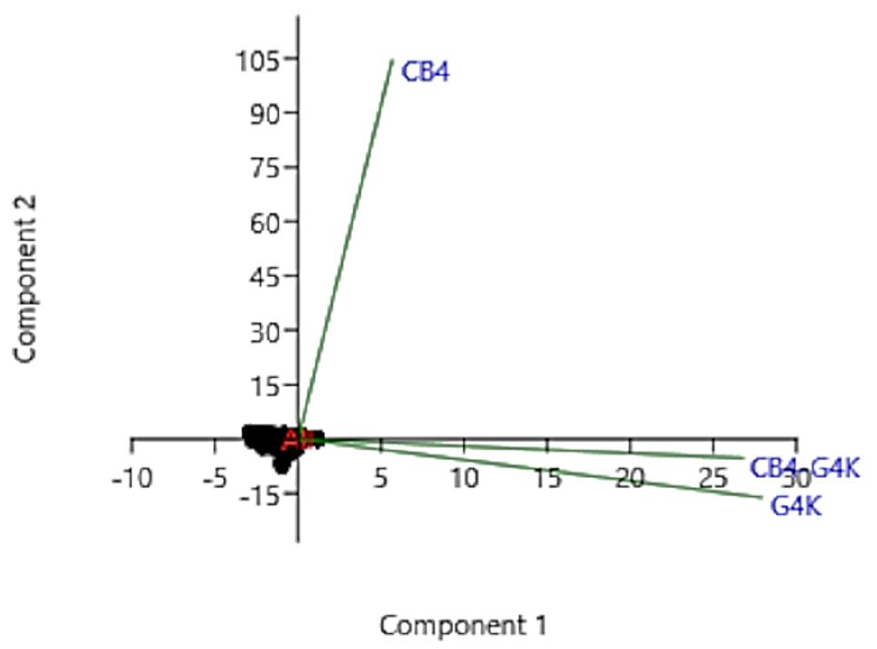
Figure 5. Principal component analysis (PCA) results represented as a score plot performed on the matrix collecting spectral data of G4K, BBB4 (named CB4 in the image), and BBB4-G4K (named CB4- G4K in the image) (PC1 vs. PC2).